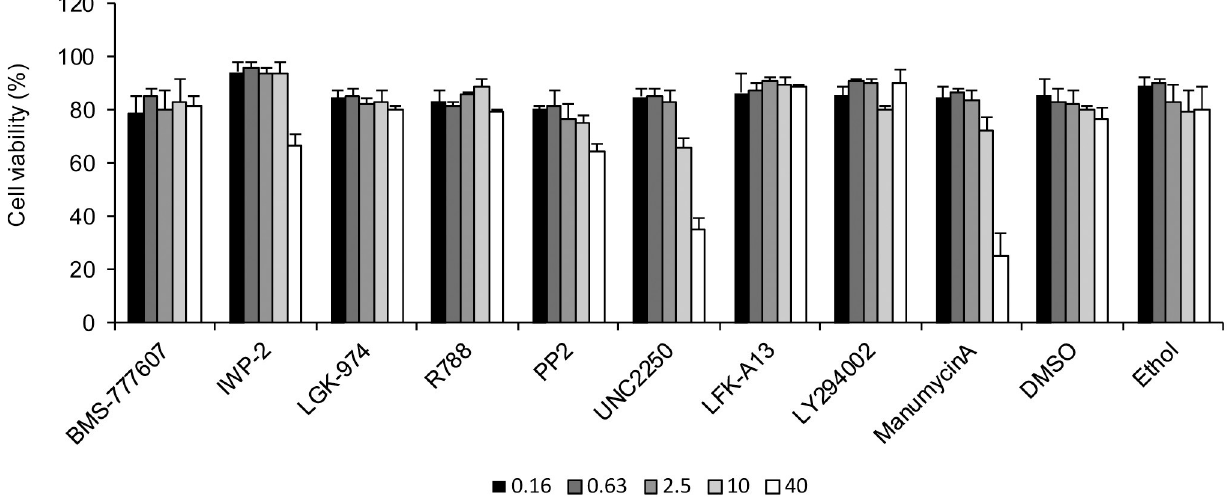
Fig 3. Cell viability in the presence of each inhibitor. HEK293 cells were treated with the indicated concentrations of each inhibitor. At 24 h after treatment, cell viability was determined using trypan blue staining.